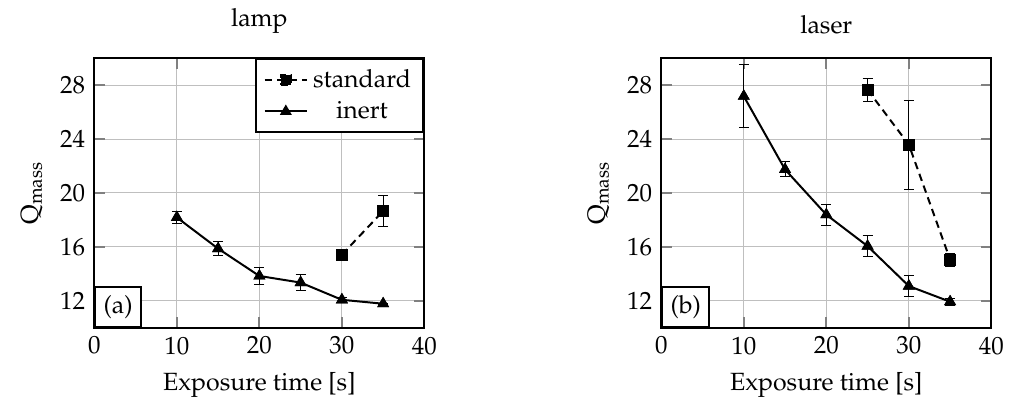
Figure 3. Degree of swelling of Poly- N -isopropylacrylamide (PNIPAAm) in water for different exposure times and UV light sources (lamp ( a ), laser ( b